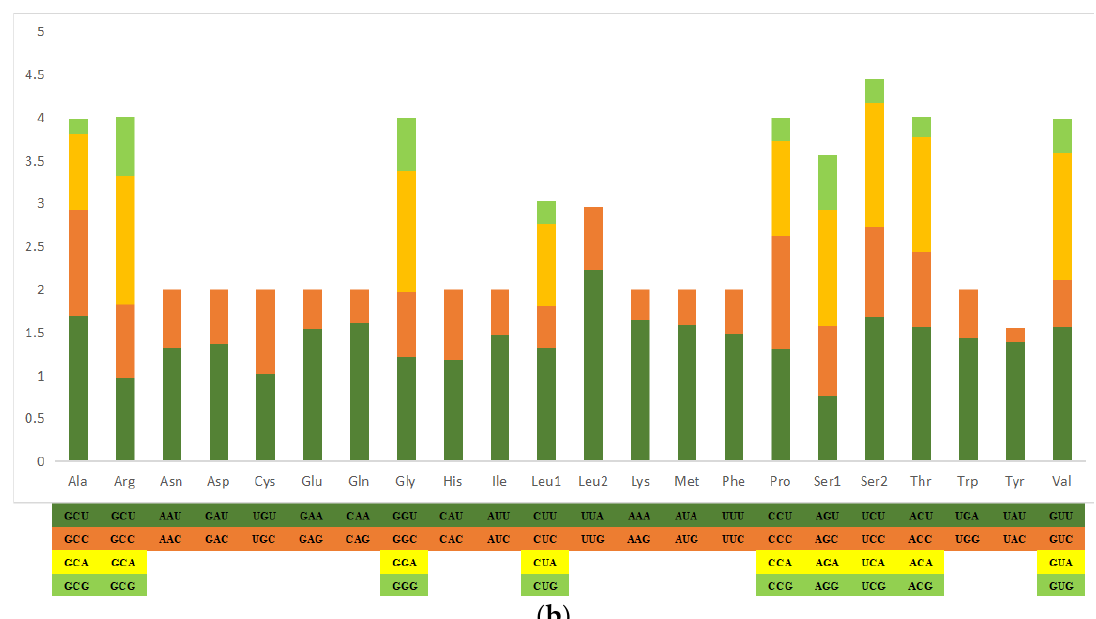
Figure 2. Amino acid composition in P. makianus mitogenome. Codons are expressed in thousands and the x-axis indicates the codon families ( a ) and the relative synonymous codon usage ( b ).